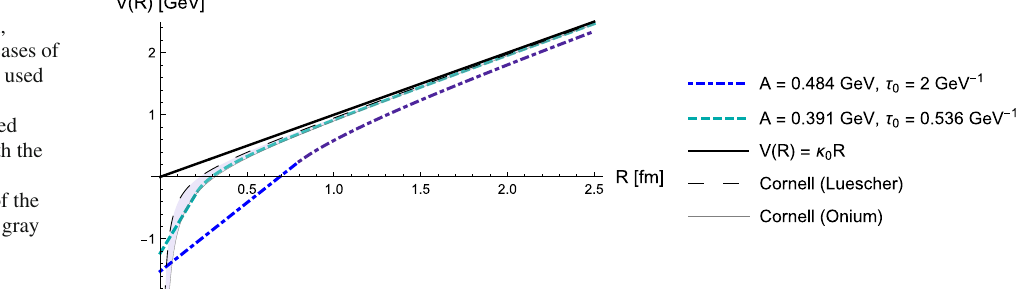
Fig. 2 The effective quark–antiquark potential, V ( R ) . The two example cases of τ -dependence parameters used in our study (shown with dot-dashed blue and dashed cyan lines), compared with the standard linear part (solid black), and two variants of the Cornell potential (shaded gray